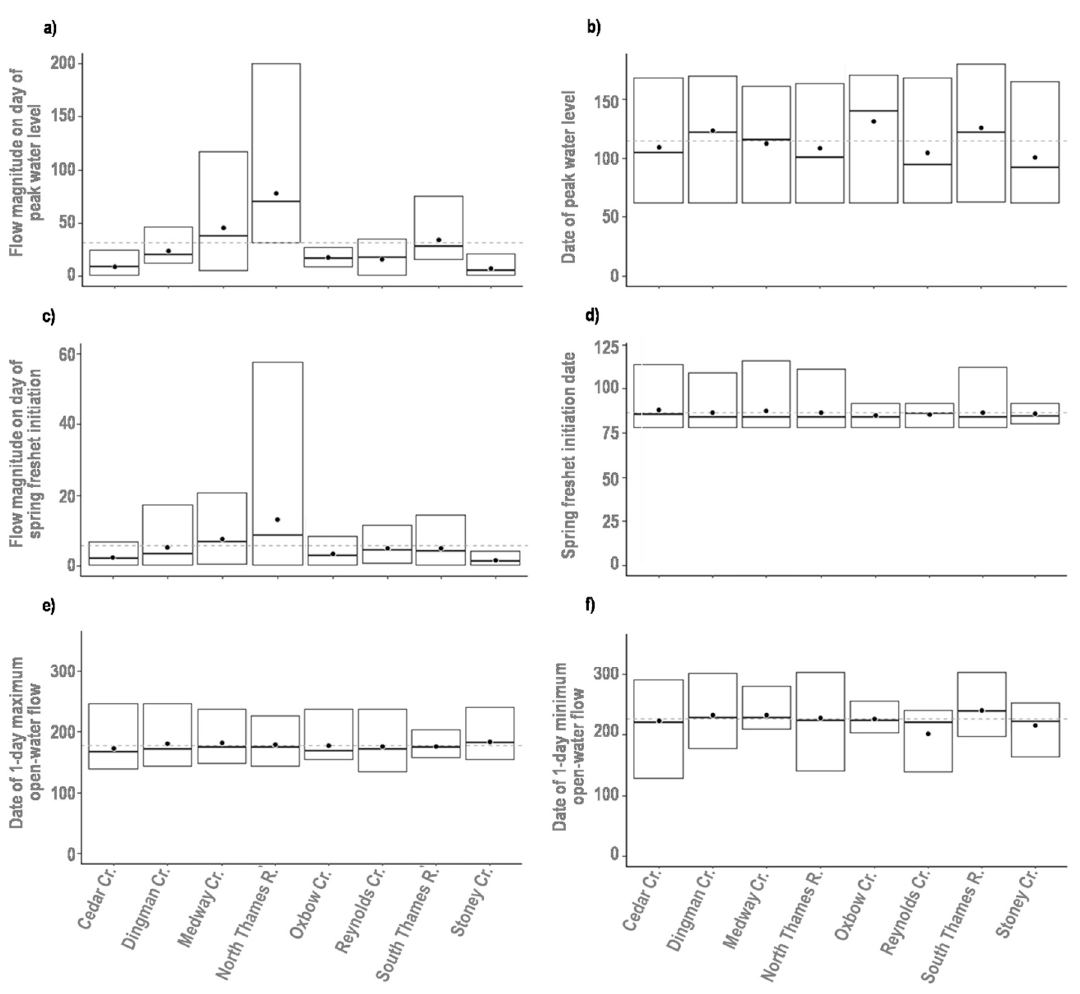
Figure 6. Box plots summarizing hydrologic measures (flow magnitude on day of peak water level ( a ), date of peak water level ( b ), flow magnitude on day of spring freshet initiation ( c ), spring freshet initiation date ( d ), date of 1-day maximum open-water flow ( e ), and date of 1-day minimum open-water flow ( f )) for eight rivers in the Upper Thames River Basin (southern Ontario, Canada) monitored for at least 14 years. Bars represent range of values, solid black lines represent median values, and black circles represent means. Gray dashed line indicates the mean of all streams combined.